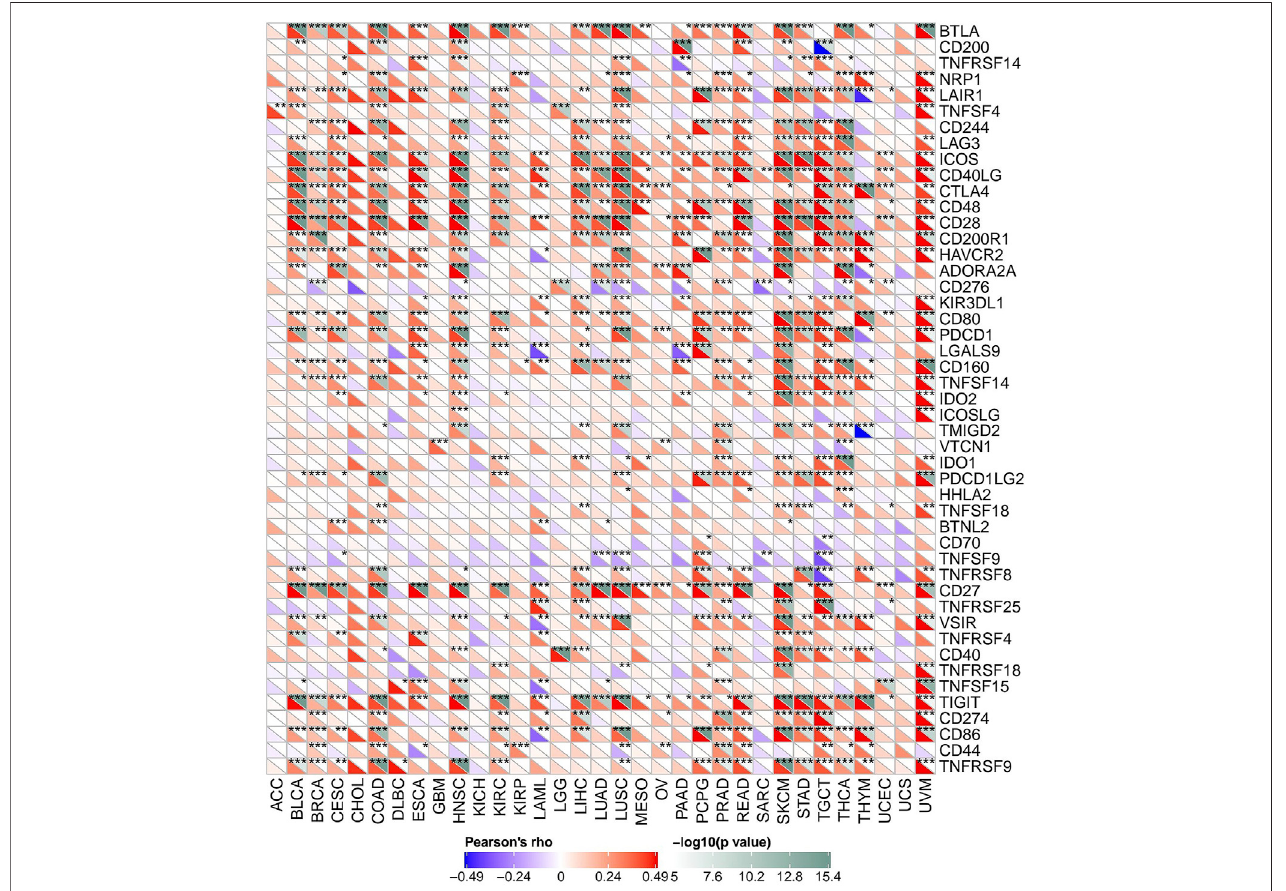
FIGURE 12 | The association between FAM46C expression and immune checkpoint genes in pan-cancer (* p < 0.05, ** p < 0.01, *** p < 0.001).